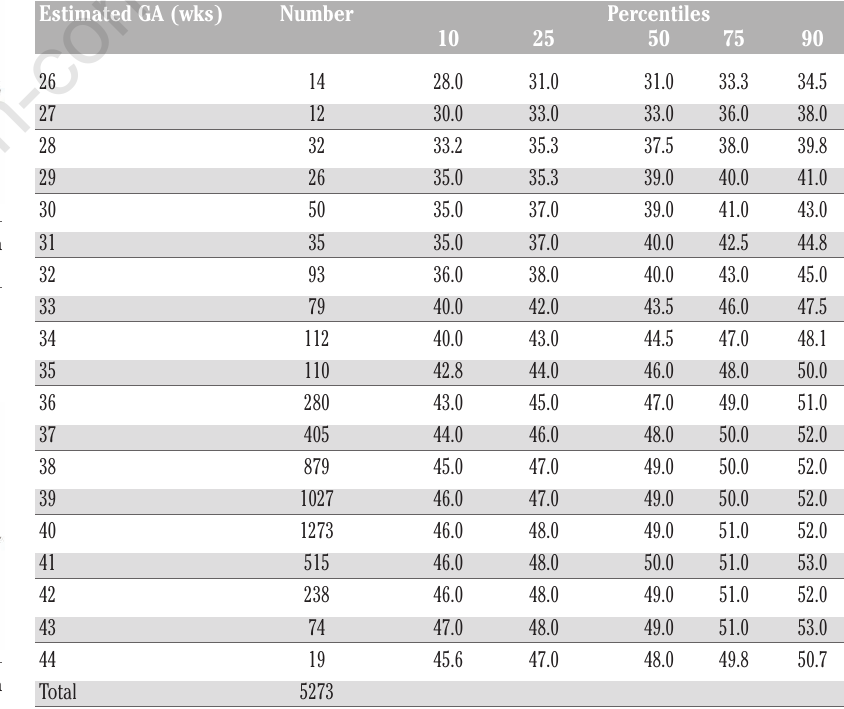
Table 2. Length percentiles by gestational age categories.